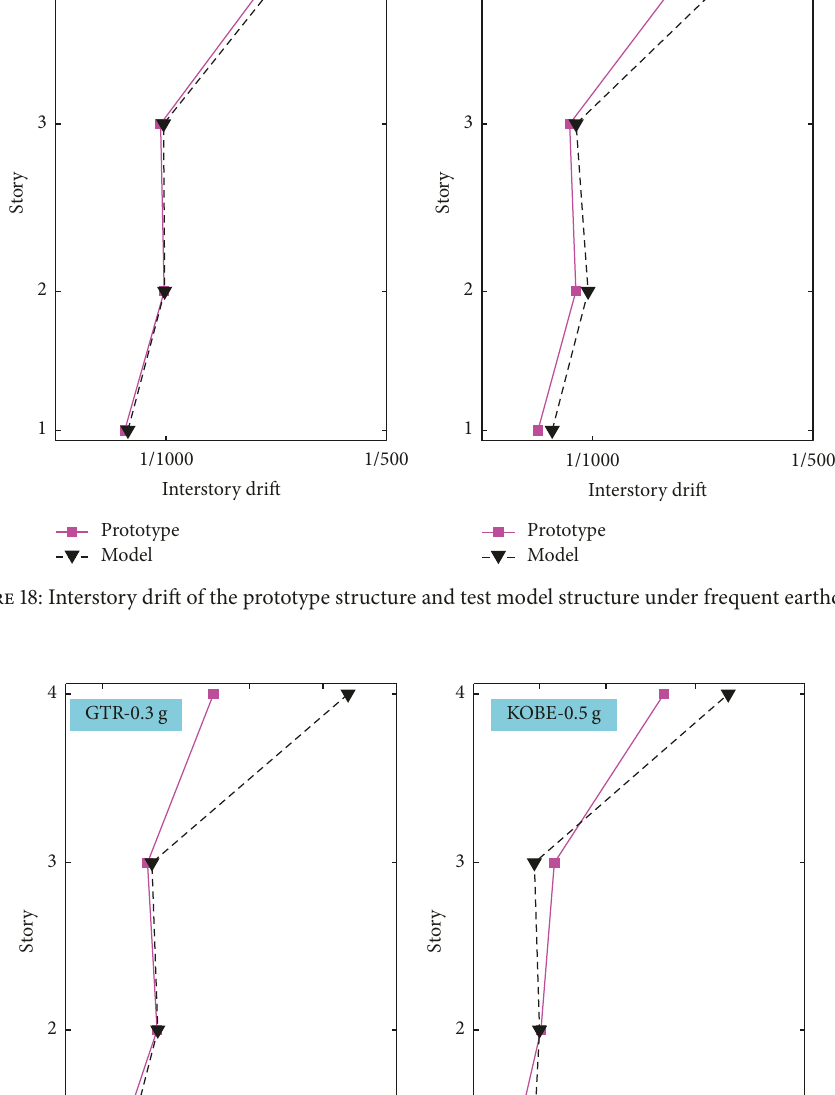
using both shaking table tests and numerical simulations, obtaining the following